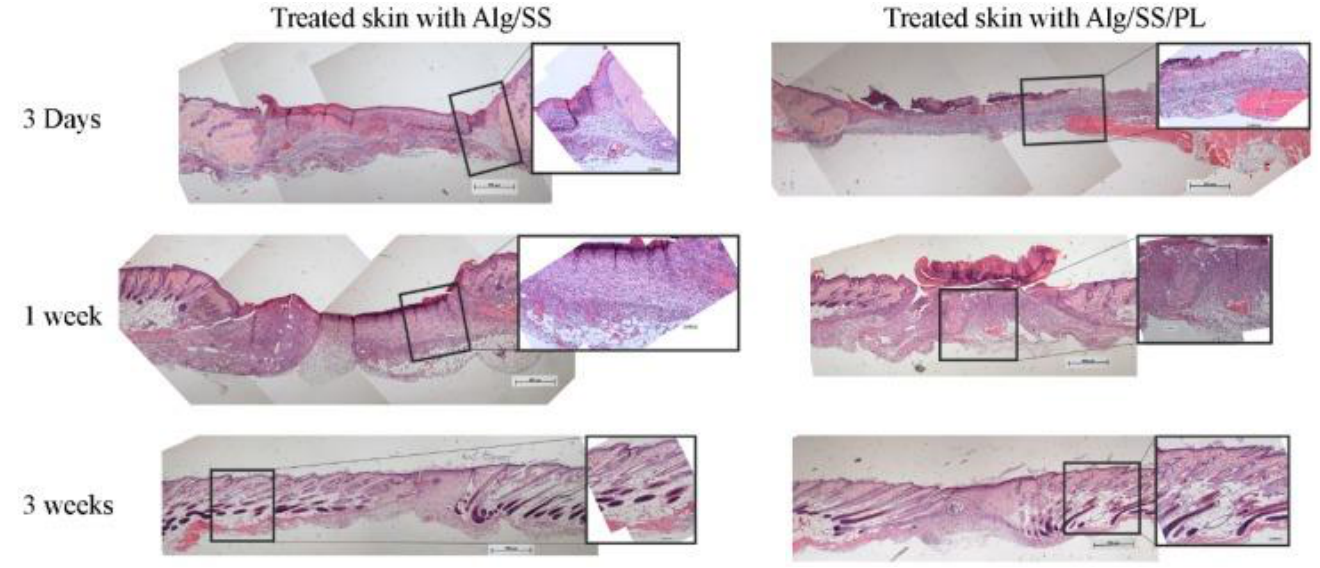
Figure 6. Full-thickness skin lesions in a mice model treated with alginate-based membranes. Haematoxylin-eosin staining of skin lesions treated with alginate-silk sericin sponge (Alg/SS) ( left ) and with alginate-silk sericin-platelet derivative sponge (Alg/SS/PL) ( right ). After 3 weeks, the lesion treated with Alg/SS/PL sponge showed a more organized tissue similar to a healthy skin. Reproduced with permission [141].